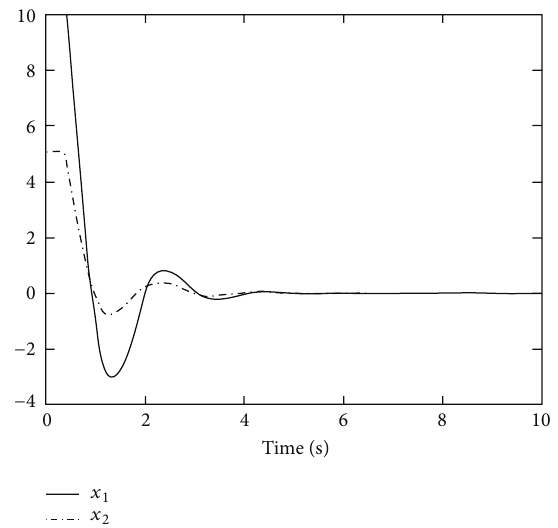
Figure 2: The simulation of the solutions 𝑥 1 (𝑘) and 𝑥 2 (𝑘) with the initial condition 𝜙(𝑘) = [10 5] 𝑇 , 𝑘 ∈ [0, 10]